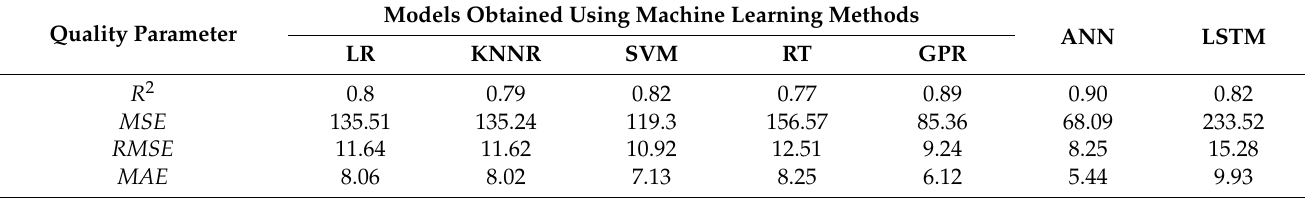
Table 7. Quality parameters of all analyzed models.